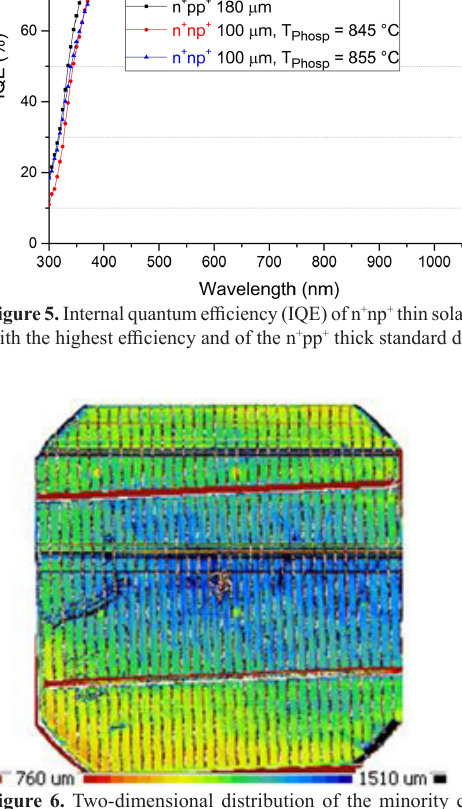
= 1200 µm). DAverage = 840 °C. Firing